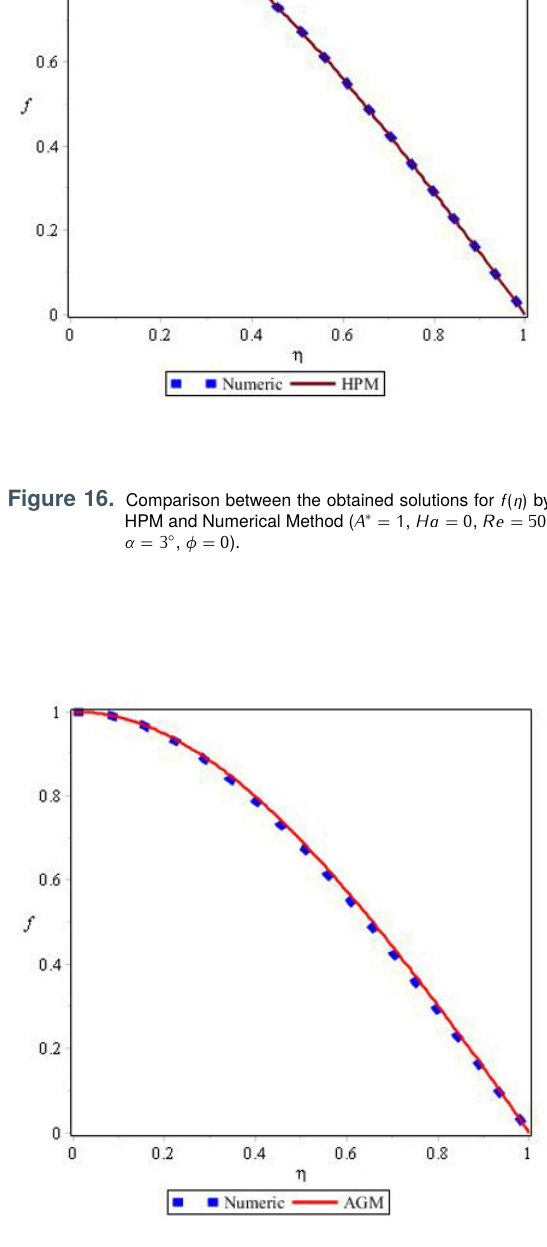
Figure 17. Comparison between the obtained solutions for f ( η ) by HPM and Numerical Method ( A ∗ = 1 , Ha = 0 , Re = 50 , α = 3 ◦ , φ = 0